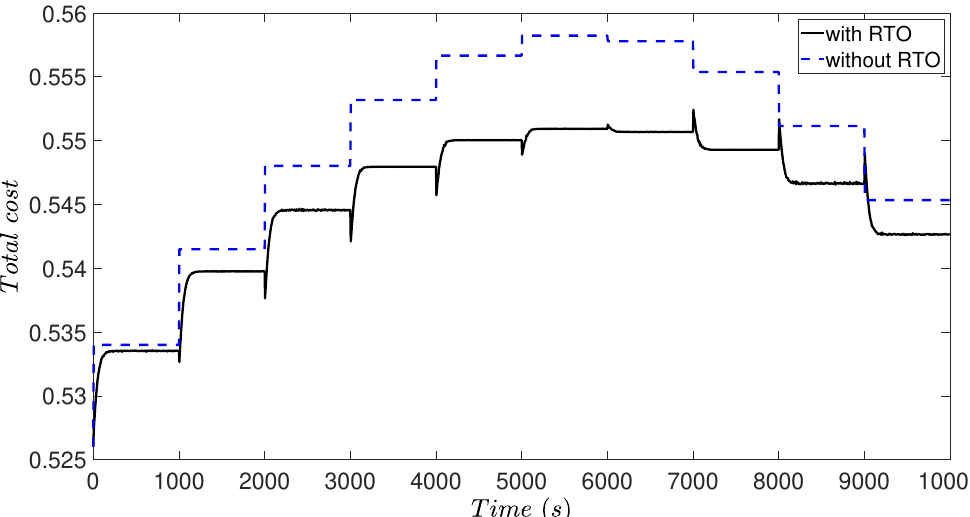
Figure 8. Comparison of the total operation cost for the CSTR example for simulations with and without RTO adapting to the heat rate price